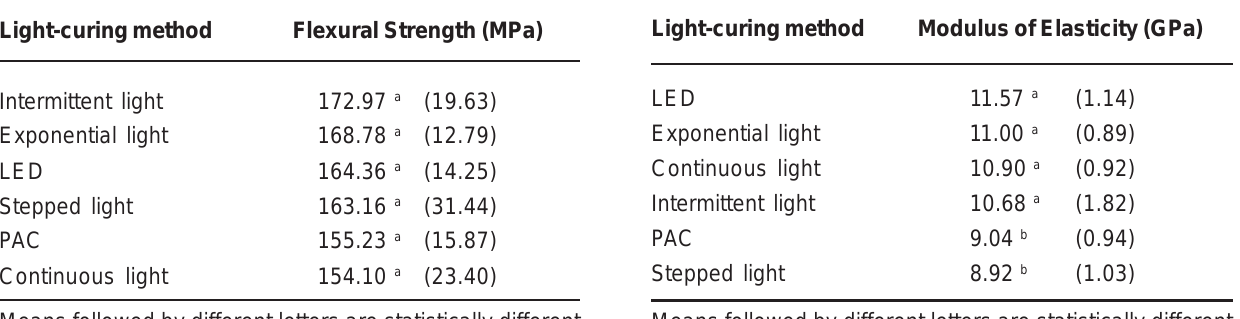
Means followed by different letters are statistically different at 5% by the Tukey